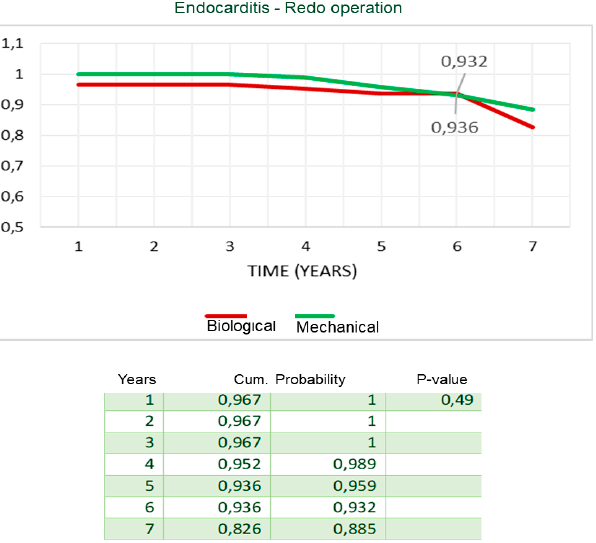
Figure 5. Freedom from endocarditis–redo operation stratified by biological vs. mechanical prostheses valved conduits (Mantel–Cox test).